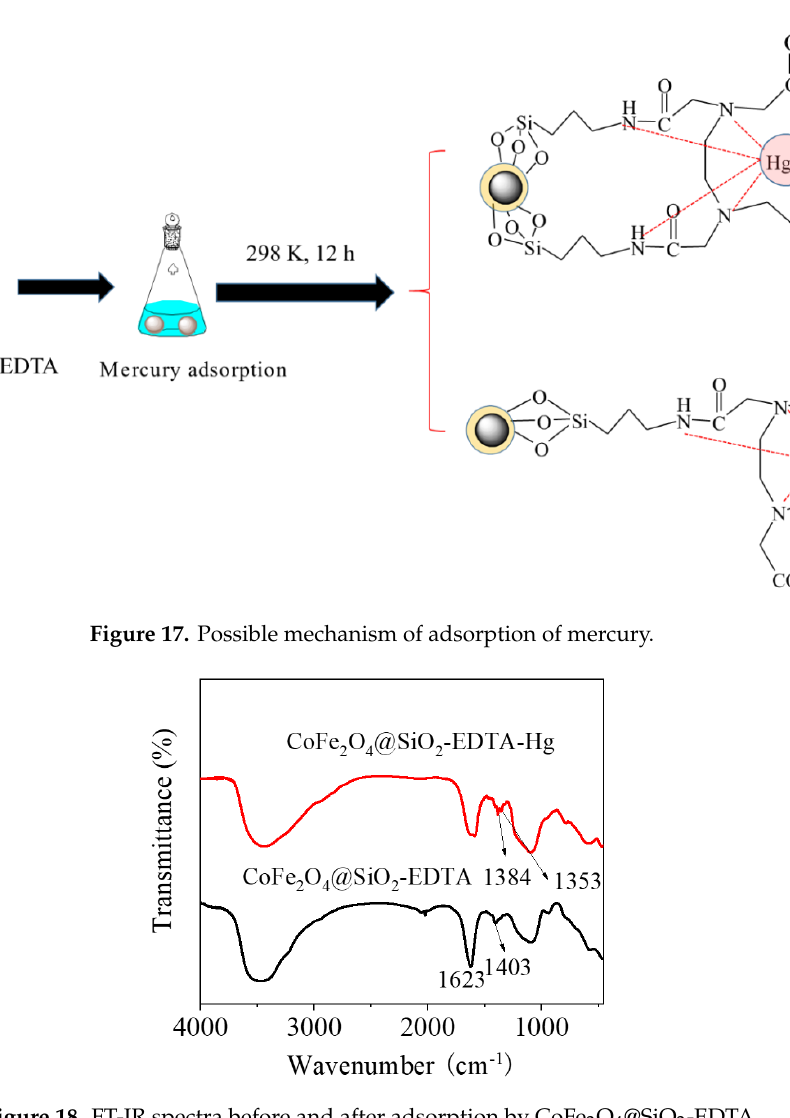
Figure 18. FT-IR spectra before and after adsorption by CoFe 2 O 4 @SiO 2 -EDTA.